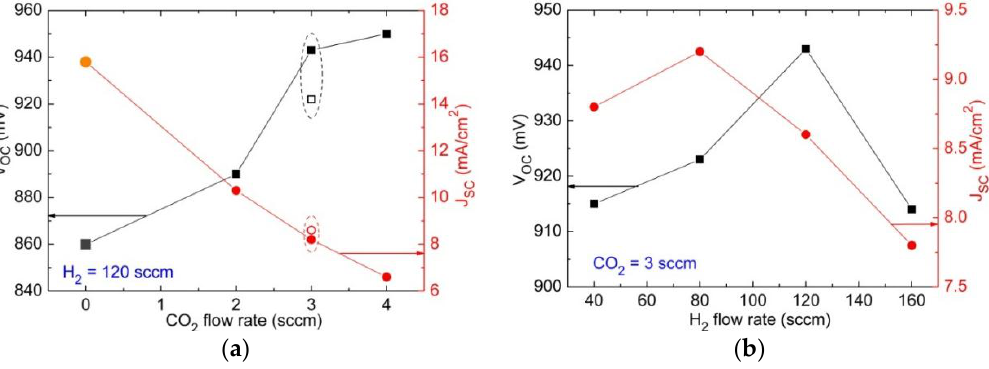
Figure 3. Evolution of open circuit voltage (left axis) and short circuit current density (right axis) for the two cell series of Figure 2: ( a ) series deposited with different CO 2 values, setting H 2 =120 sccm; ( b ) series deposited with different H 2 flow rates, setting CO 2 = 3 sccm. The open symbols in ( a ) correspond to the cell with absorber layer grown at 40 mW/cm 2 , while in all the other cases the power density was 28 mW/cm 2 . The values for the a-Si:H reference cell in ( a ) are shown in slightly modified color to remind that the H 2 dilution is different in this case.